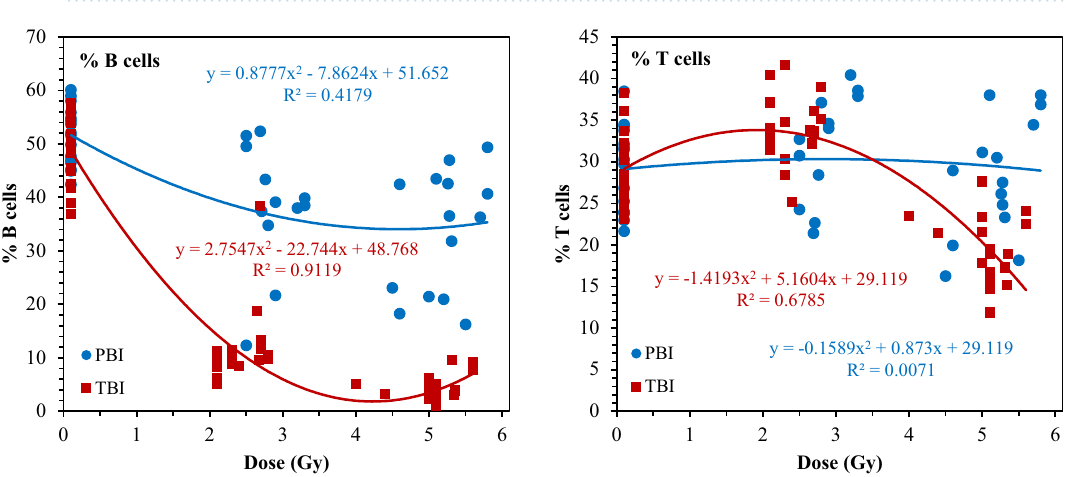
y = 0.8777x 2 - 7.8624x + 51.652 R² = 0.4179